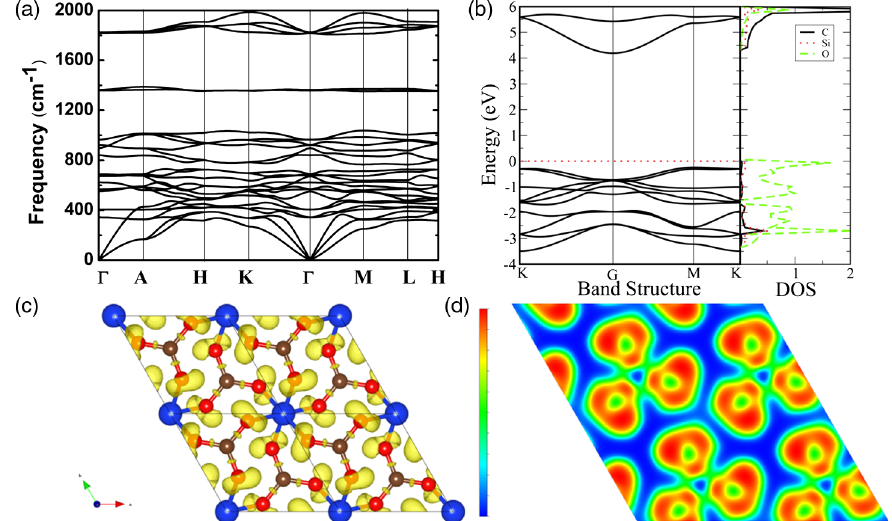
FIG. 5 (color online). (a) Computed phonon spectra of the 1 = 2 -I structure at ambient condition. (b) The band structure and the projected density of states [ K ð − 1 = 3 ; 2 = 3 ; 0 Þ , M ð 0 ; 0 ; 1 = 2 Þ ]. (c) The 3D ELF isosurfaces with ELF ¼ 0 . 83 . (d) The 2D figure of the ELF projected on the lower C-O layer. Color code in (c): red (O), brown (C), and blue